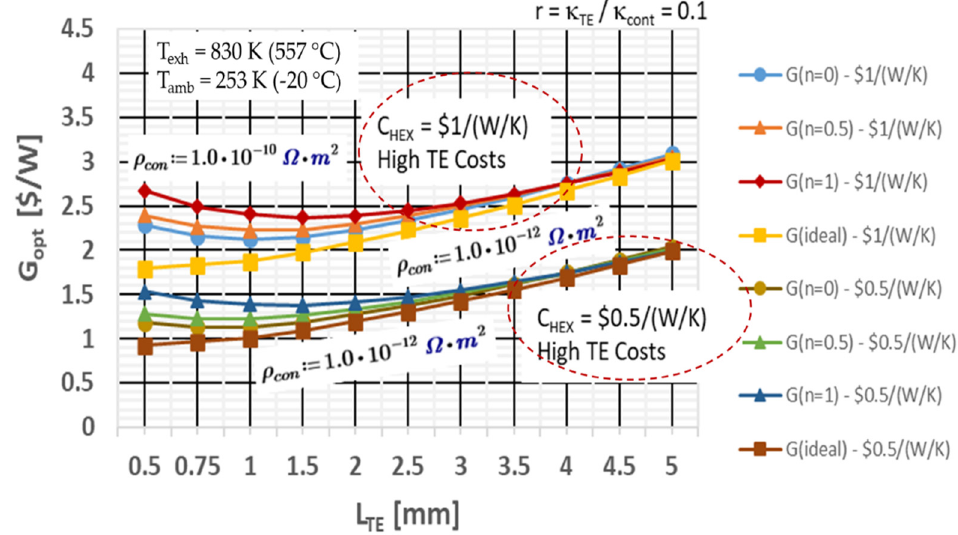
Figure 21. Decreased Electrical and Thermal Contact Interface Effects on Overall TEG Cost Minimization for Various Heat Exchanger Cost Parameters and Cost Sensitivities to TE Manufacturing Costs (r = 0.1).